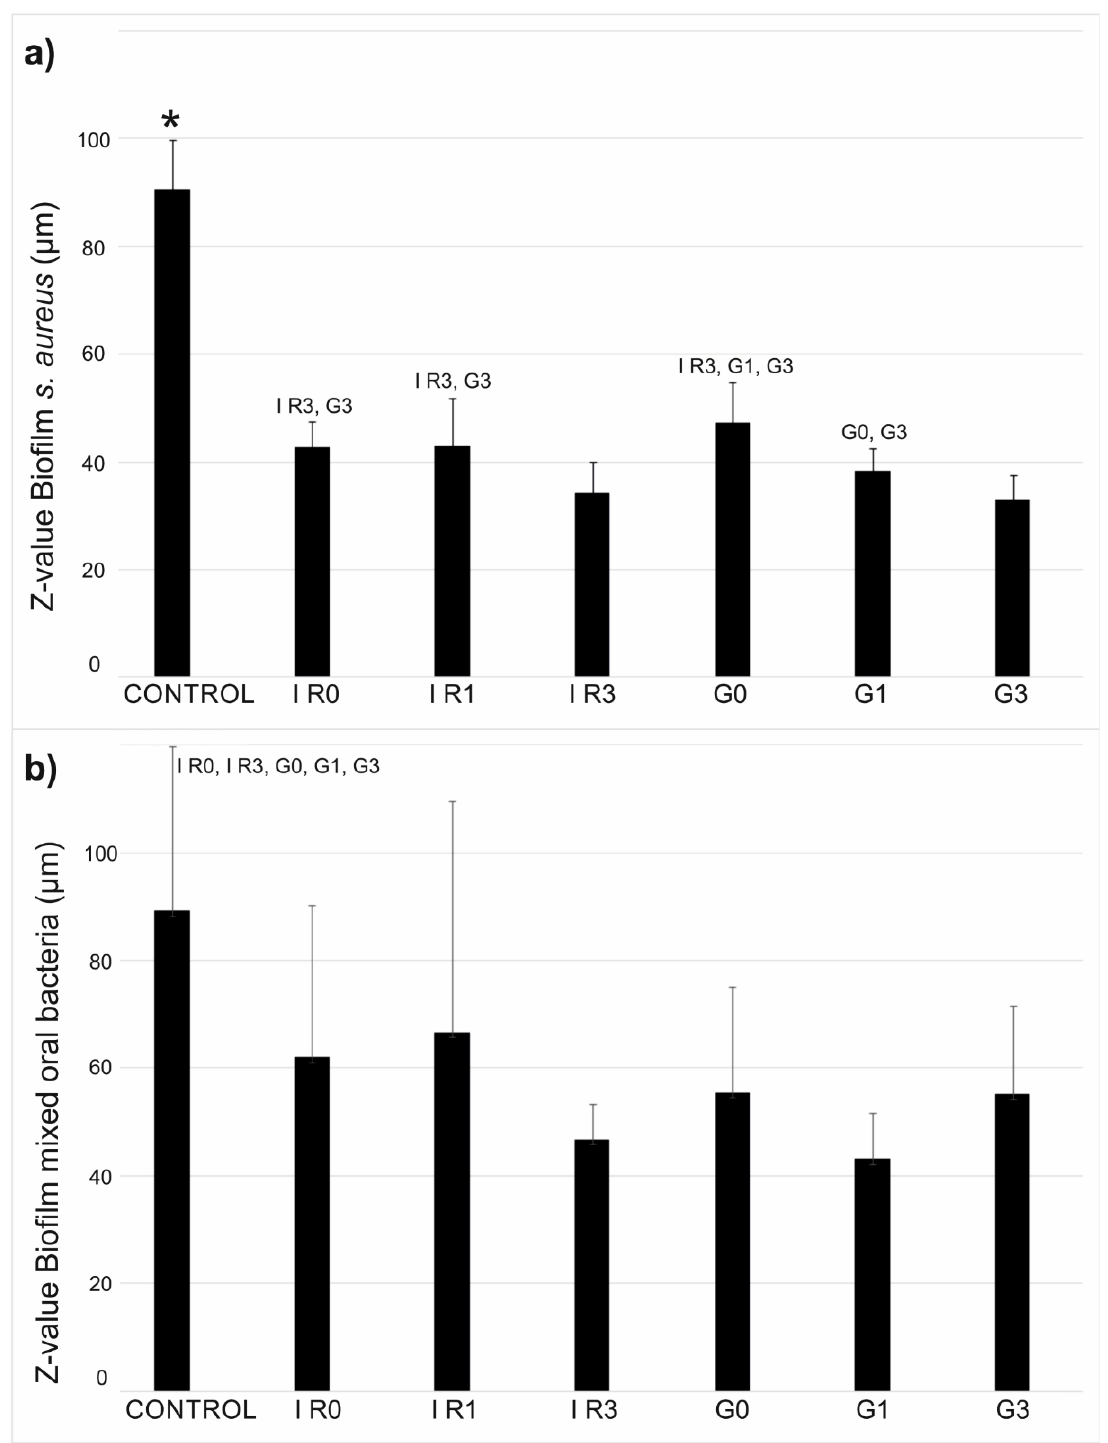
Figure 13. Mean thickness values of the biofilms of ( a ) S. aureus and ( b ) mixed oral bacteria. Control sample is the bare titanium disc without Ag-NPs. The other samples correspond to Ti discs with immobilized Ag-NPs obtained according to conditions of Table 3. The error bars represent the standard deviation (* p < 0.05 with respect all the other materials).